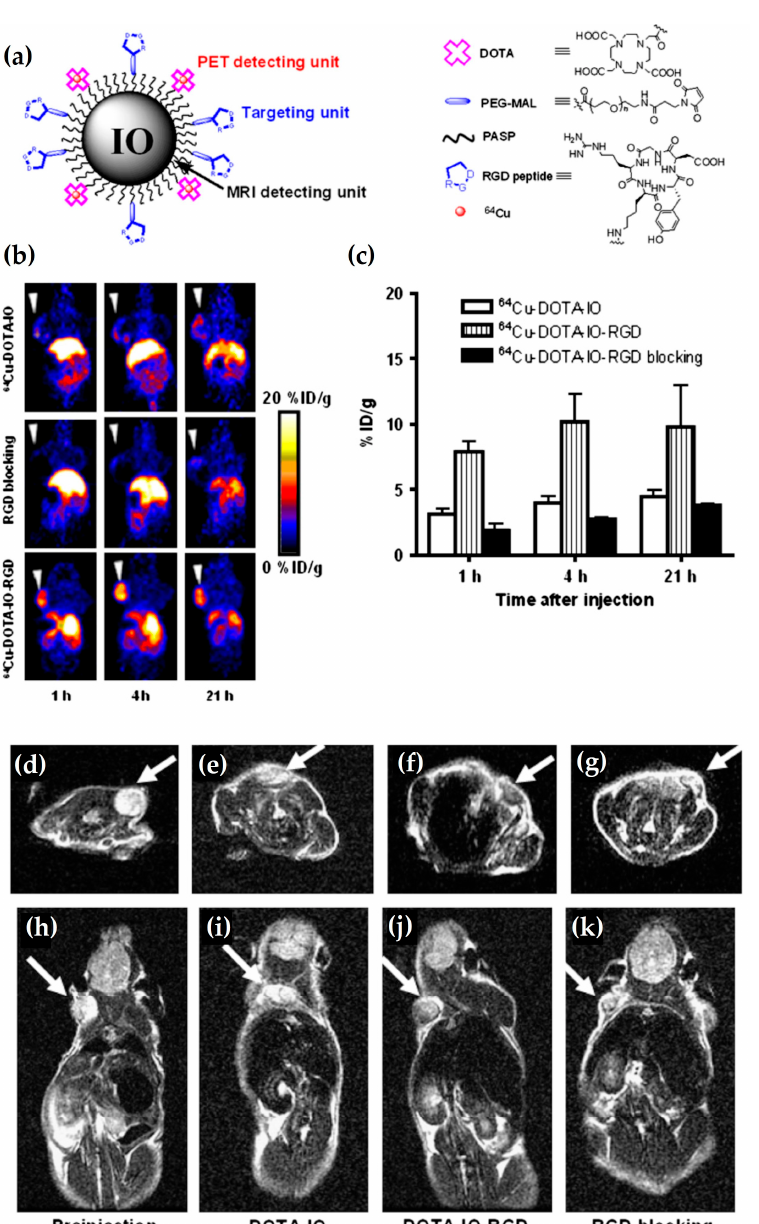
Figure 9. ( a ) Schematic illustration of RIONs, namely 64 Cu-DOTA-IONs-RGD, for PET/MR imaging; ( b ) Representative coronal PET images of U87MG tumor bearing mice injected with 3.7 MBq of 64 Cu-DOTA-IONs (top row), 64 Cu-DOTA-IONs-RGD with 10 mg of c(RGDyK) peptide per kg (middle row) and 64 Cu-DOTA-IONs-RGD (bottom row) at 1, 4, and 24 h p.i.; ( c ) Time-activity diagram of tumors injected with 3.7 MBq of 64 Cu-DOTA-IONs, 64 Cu-DOTA-IONs-RGD, 64 Cu-DOTA-IONs-RGD with blocking dose of c(RGDyK) peptide; Representative ( d – g ) axial and ( h – k ) coronal T 2 -weighted MR images of U87MG tumor bearing mice ( d , h ) before and 4 h p.i. with ( e , i ) non-radiolabeled DOTA-IONs, ( f , j ) non-radiolabeled DOTA-IONs-RGD and ( g , k ) non-radiolabeled DOTA-IONs-RGD with blocking dose of c(RGDyK) peptide. The U87MG tumor is indicated by the white arrows (This research was originally published in JNM. Lee, H.-Y., Li, Z., Chen, K., Hsu, A.R., Xu, C., Xie, J., Sun, S., Chen, X. PET/MRI Dual-Modality Tumor Imaging Using Arginine-Glycine- Aspartic (RGD)—Conjugated Radiolabeled Iron Oxide Nanoparticles. J. Nucl. Med. 2008; 49(8): 1371–1379 © SNMMI